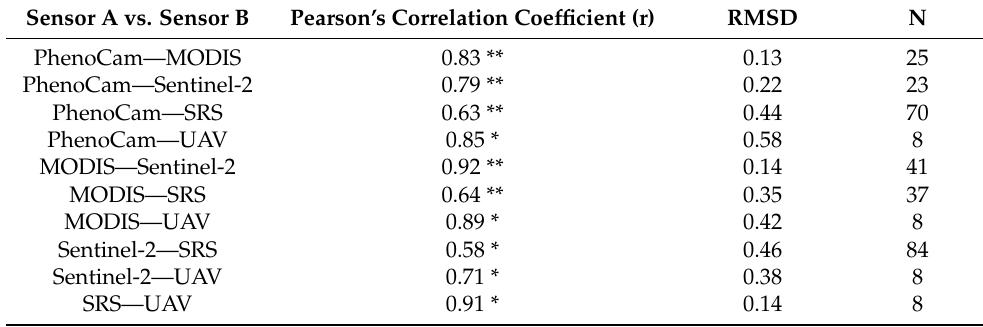
Table 6. Pearson’s correlation coefficient (r) and RMSD for PhenoCam VIgreen , MODIS VIgreen , Sentinel- 2 VIgreen , SRS VIgreen , and UAV VIgreen . N is sample size.